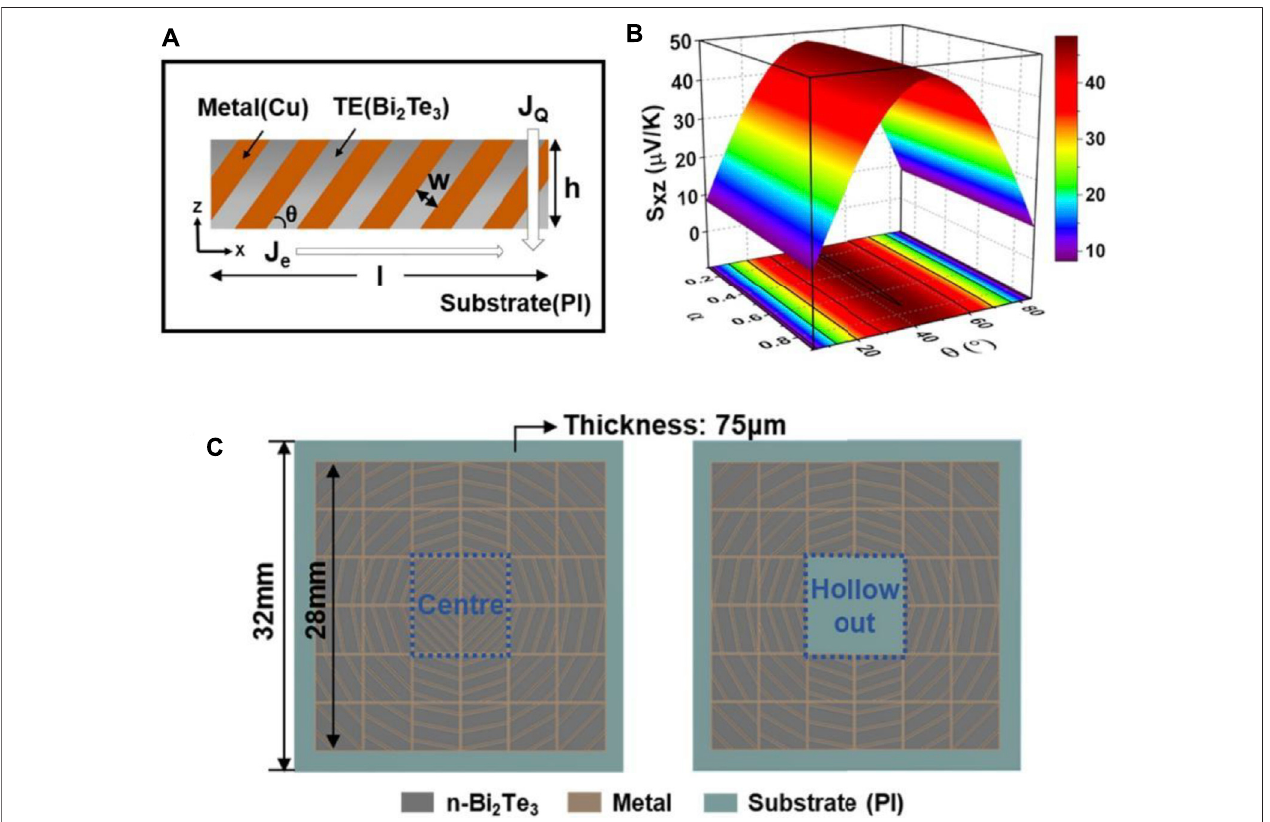
FIGURE1|(A) Schematicdiagramofthein-planetransversethin- fi lmthermoelectricdevice. (B) Theoreticaleffectsof θ and α onthetransverseSeebeckcoef fi cient S xz . (C) Design diagram of the thin- fi lm thermal meta-device with a dual-function of thermal shield and generation.